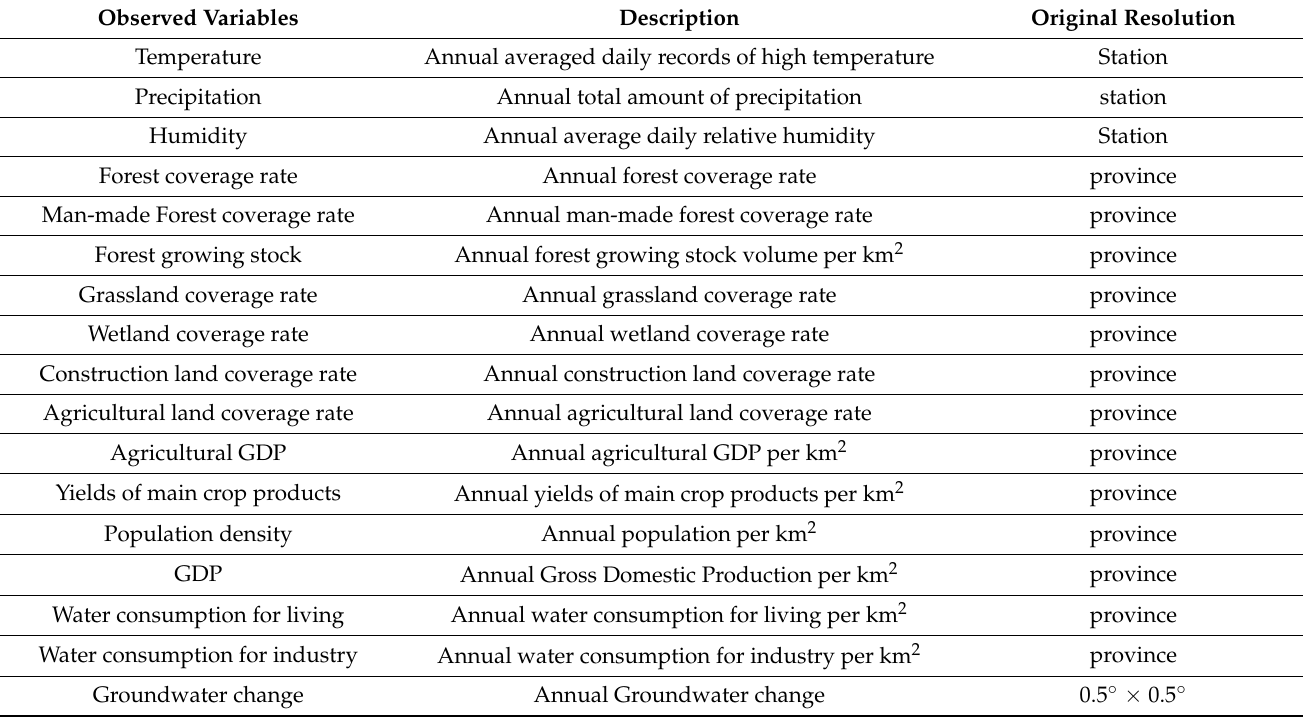
Table 1. List and description of potential observed variables